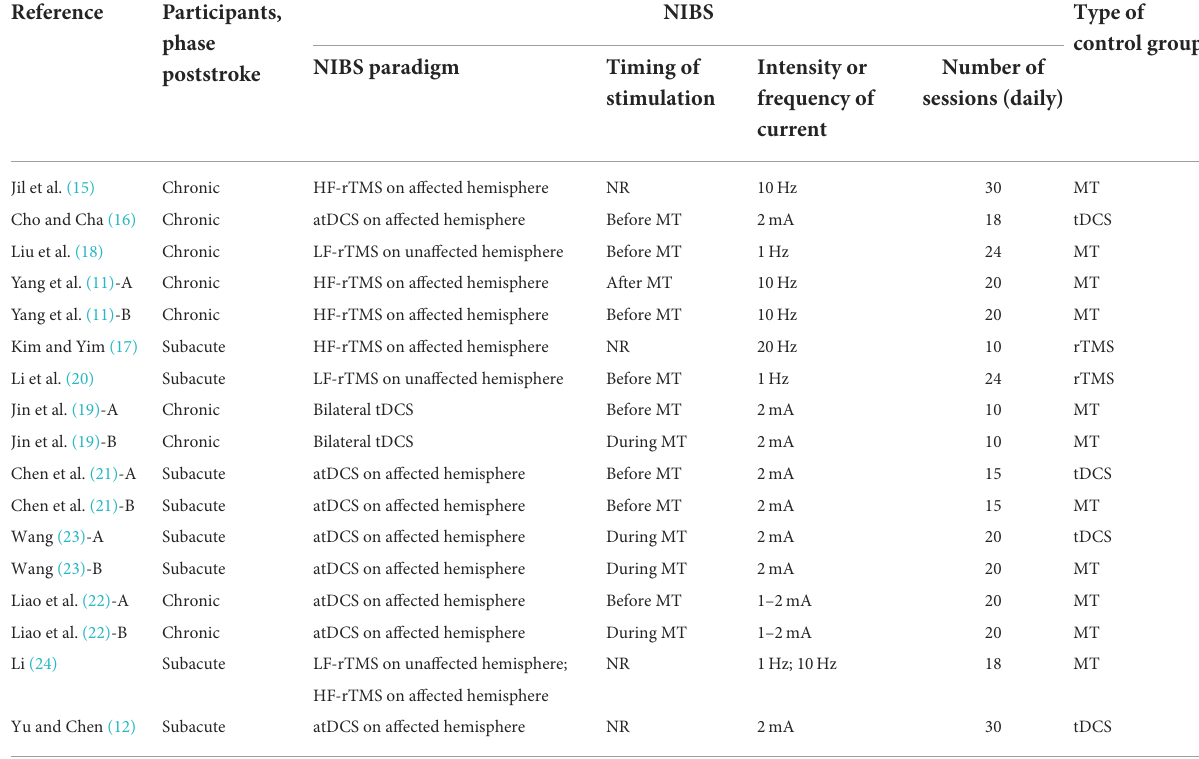
TABLE 2 Interventions reported in the